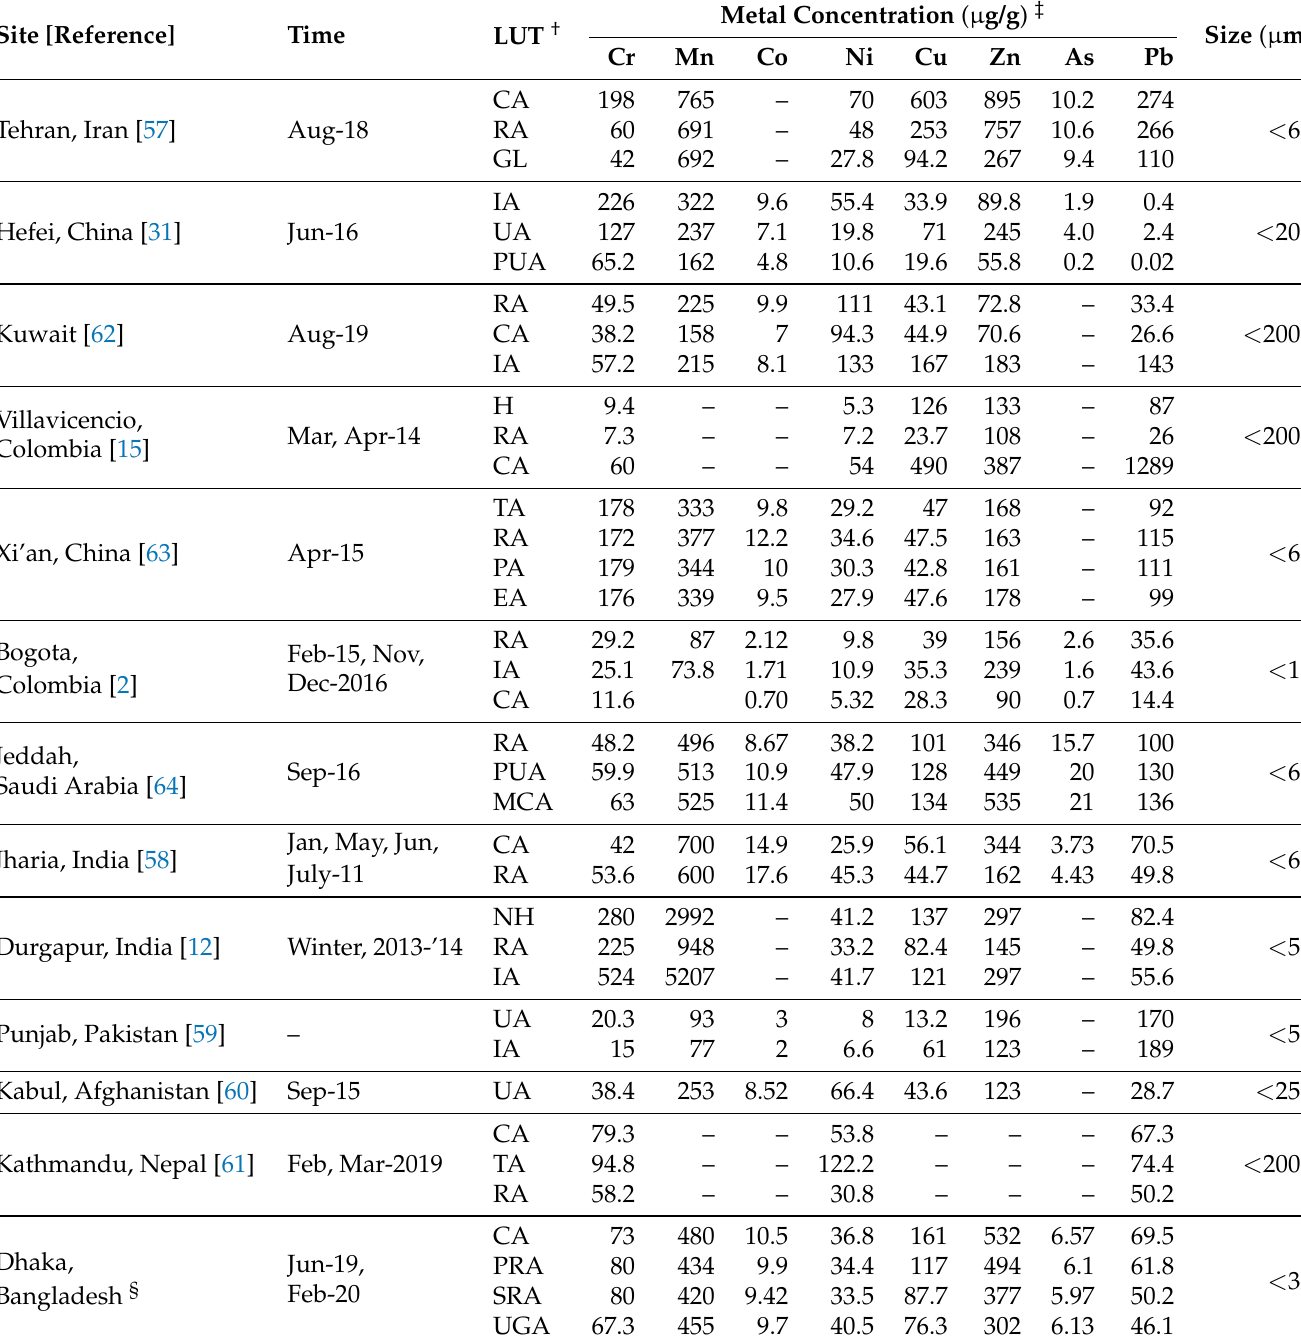
Table 1. Comparison of heavy metal concentrations in road dust in different cities of the world. Site